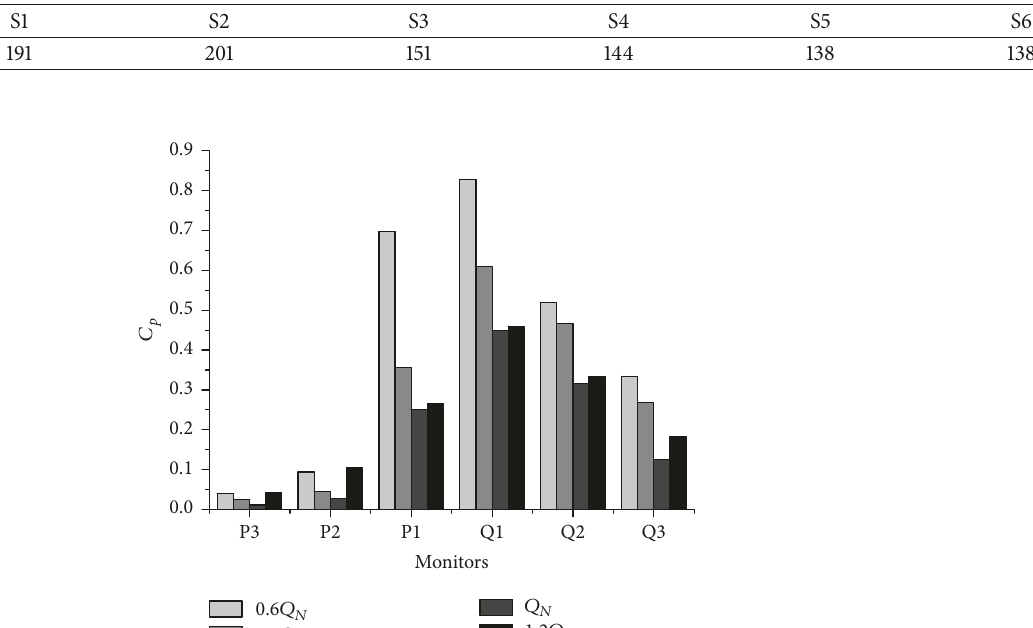
Table 5: Phase difference of monitor S series.